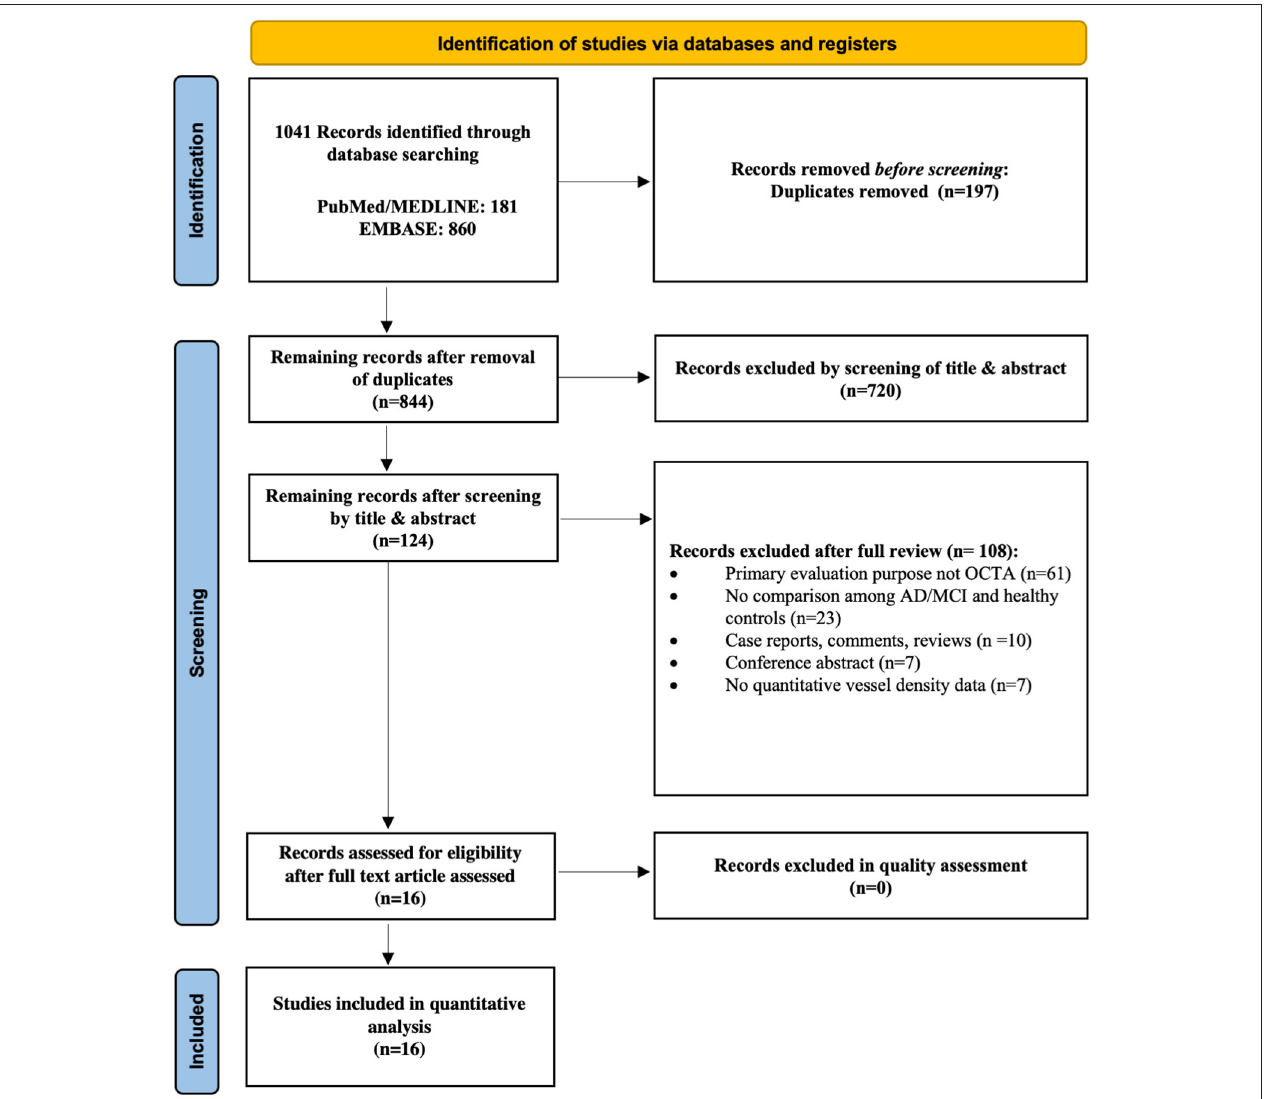
FIGURE 1 | Flow chart of search strategy. The flow chart illustrates the search strategy according to the guidelines of the Preferred Reporting Items for Systematic reviews and Meta-Analyses (PRISMA) 2020